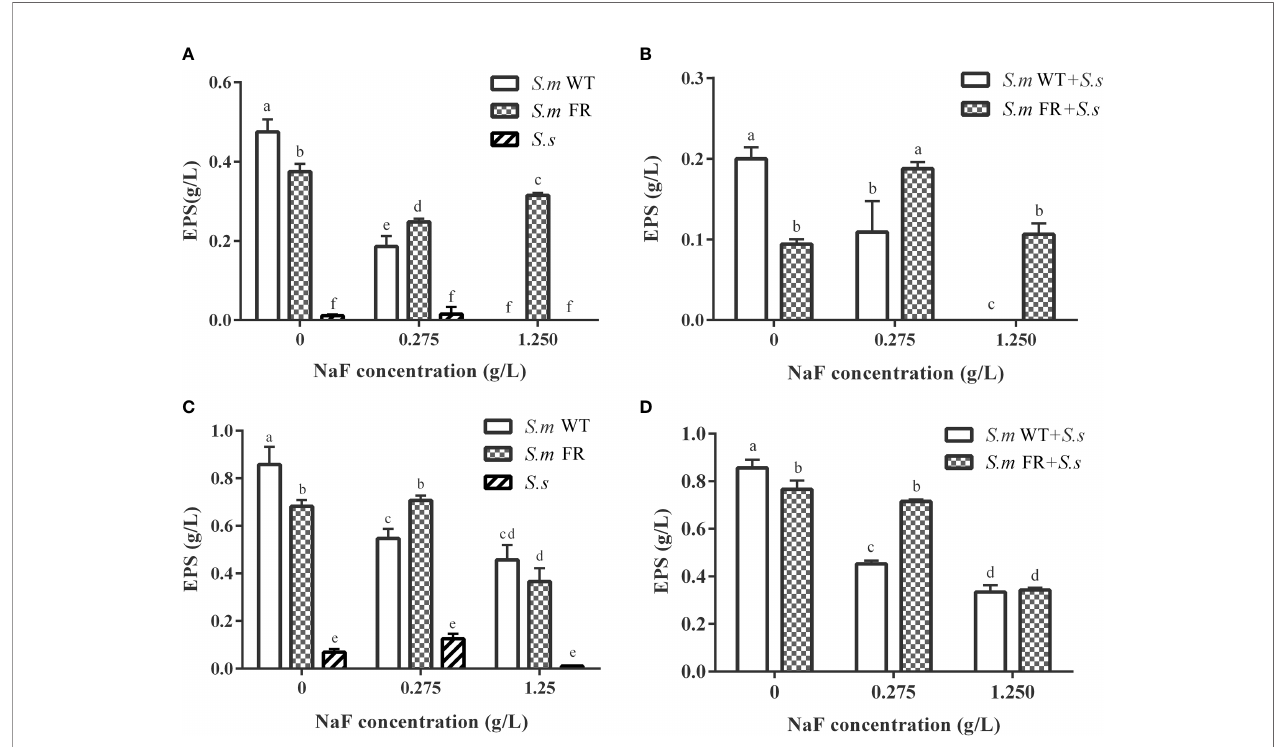
FIGURE 6 | Water-insoluble exopolysaccharide measured using anthrone method. (A) Single-species bio fi lm formation. (B) Dual-species bio fi lm formation. (C) Pre-formed single-species bio fi lms. (D) Pre-formed dual-species bio fi lms. The same letters indicate no statistical difference, and different letters indicate a signi fi cant difference between groups ( P <